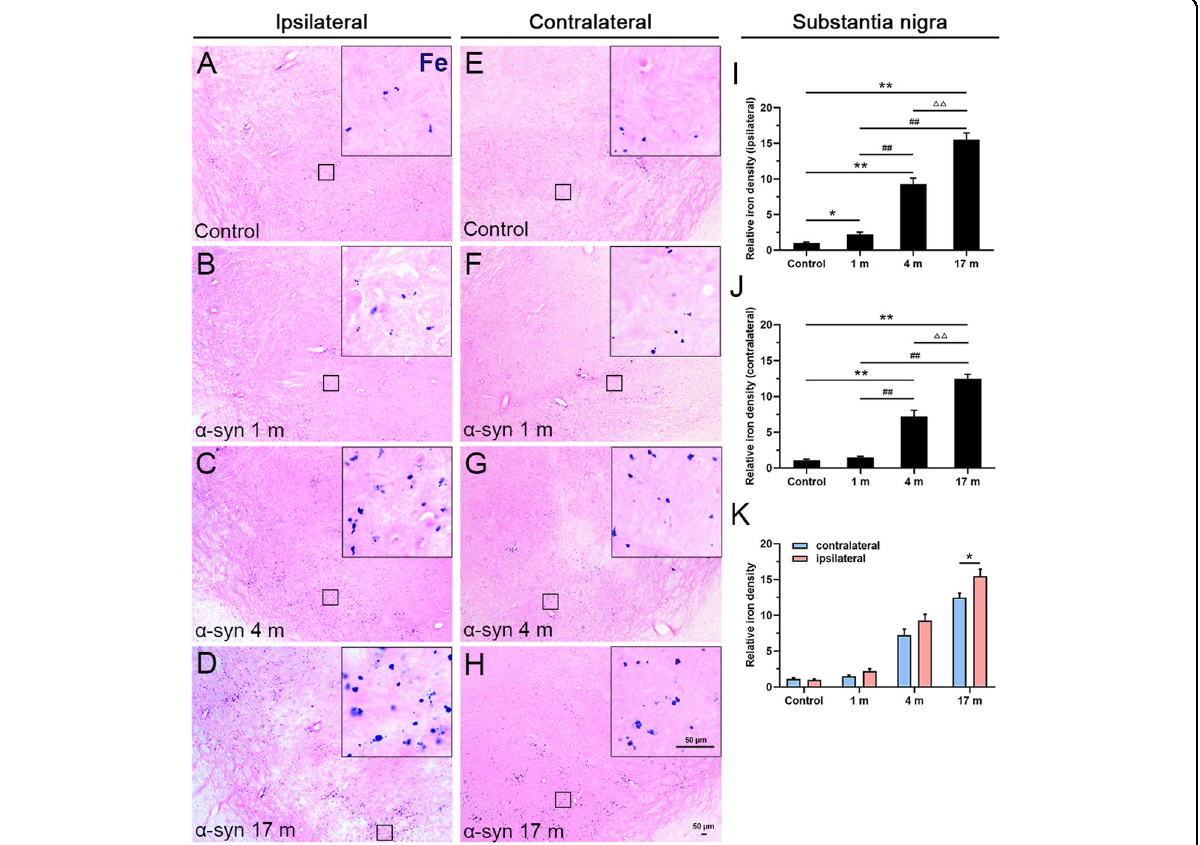
Fig. 1 Ferric iron deposition in the substantia nigra. Chemical staining of iron ions showed a gradual increase in iron deposition, 1 ( B ), 4 ( C ), and 17 ( D ) months after the treatment with α -syn PFFs, compared to the control ( A ) in the ipsilateral side. E – H Chemical staining of iron ions in the control ( E ) and 1 ( F ), 4 ( G ), and 17 months ( H ) after treatment with α -syn PFFs in the contralateral side. The inset images depict the enlarged small boxes in A – H . I – K Quantitative analyses of the iron deposition density in the substantia nigra (ipsilateral side: I ; contralateral side: J ; both sides: K ). Iron deposition staining levels were quanti fi ed with Image-Pro Plus software as the relative optical density above the background. α -Syn, α -synuclein. The data are presented as the mean ± SEM of three independent experiments. n = 3 in each group and time points. * p < 0.05 and ** p < 0.01 vs. control group, ## p < 0.01 vs. 1-month group, ΔΔ p < 0.01 vs. 4-month group, one-way ANOVA ( I , J ). * p < 0.05 vs. contralateral group, Tukey ’ s